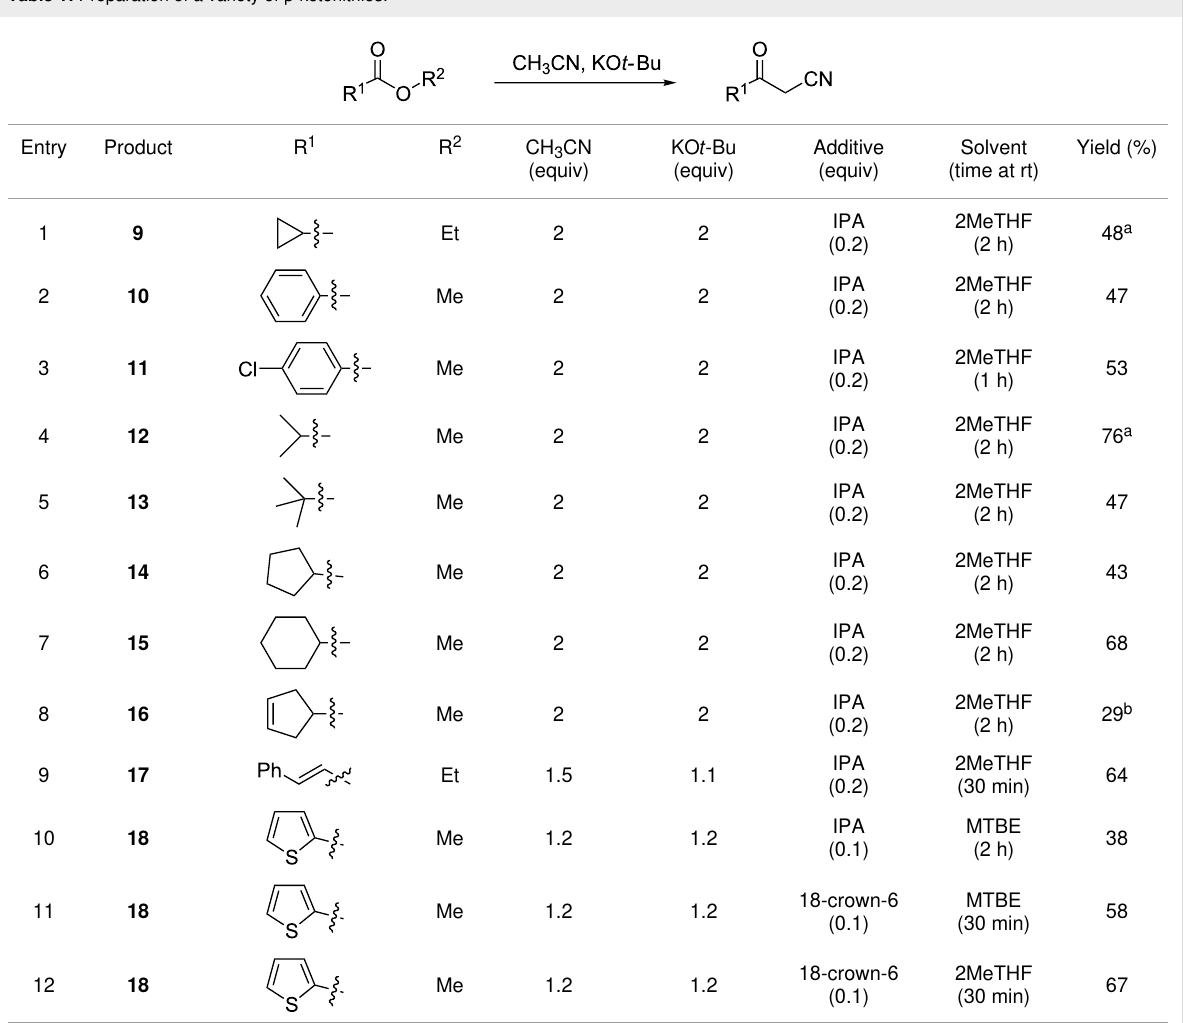
Table 1: Preparation of a variety of β